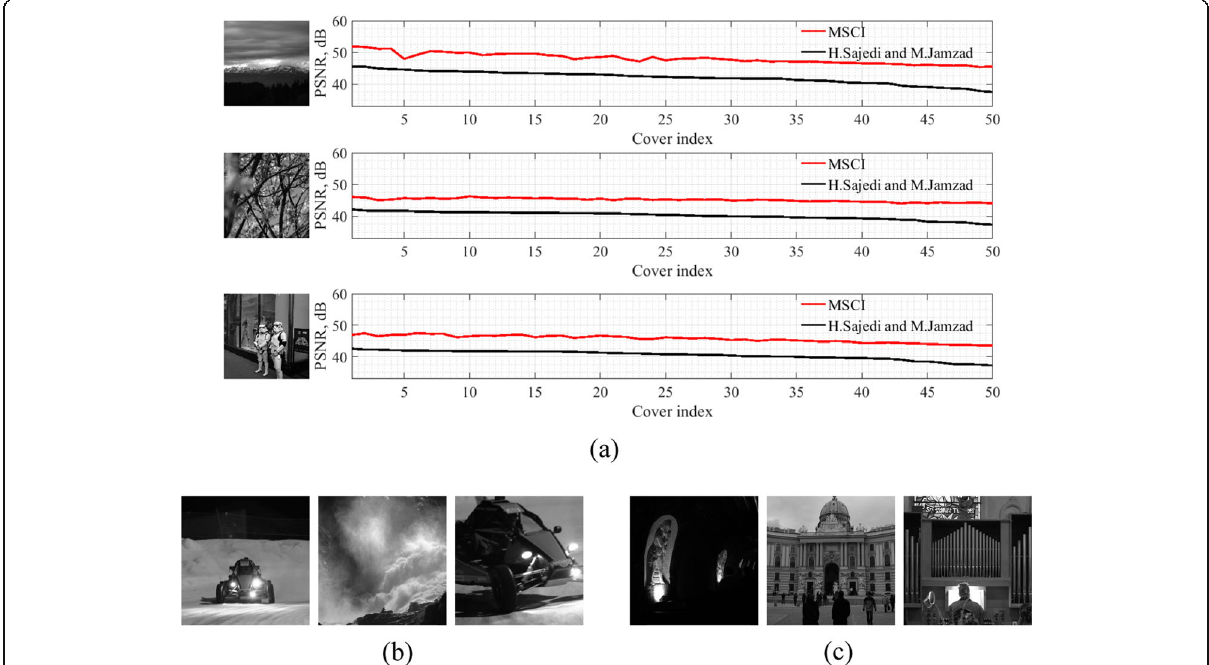
Fig. 8 a Comparing PSNR values of the stego-images obtained with two different cover selection and embedding techniques for three secret images, ( b ) the best covers chosen for the secret images with the MSCI framework, and ( c ) with the algorithm proposed in [3]